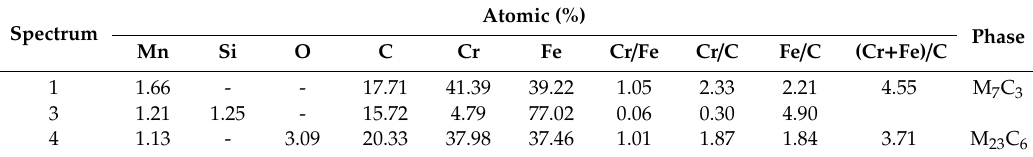
Table 2. Chemical composition of observed phases determined by EDX (at